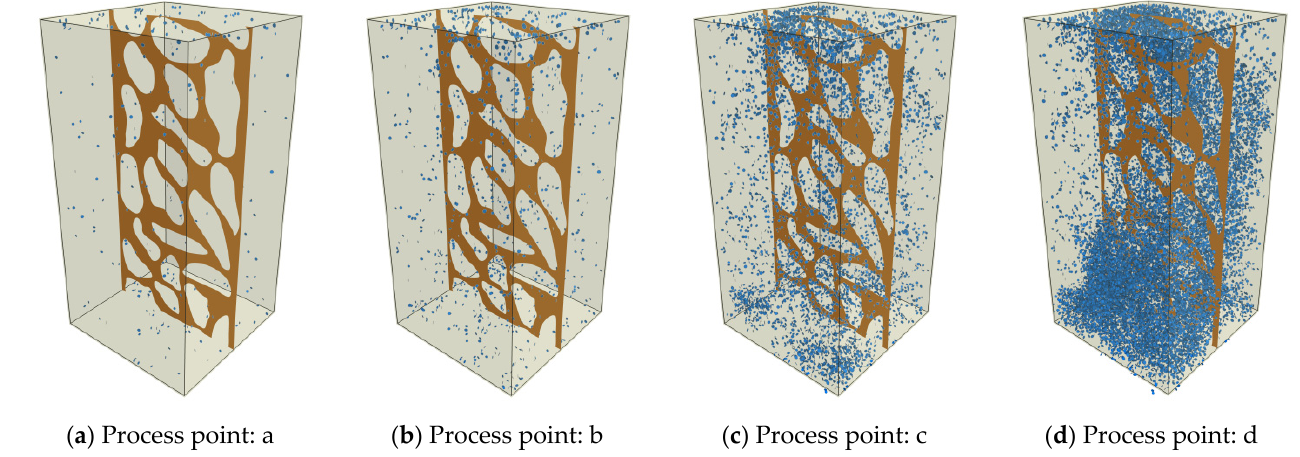
Figure 13. Microcrack development in specimen S − 90 − K1.